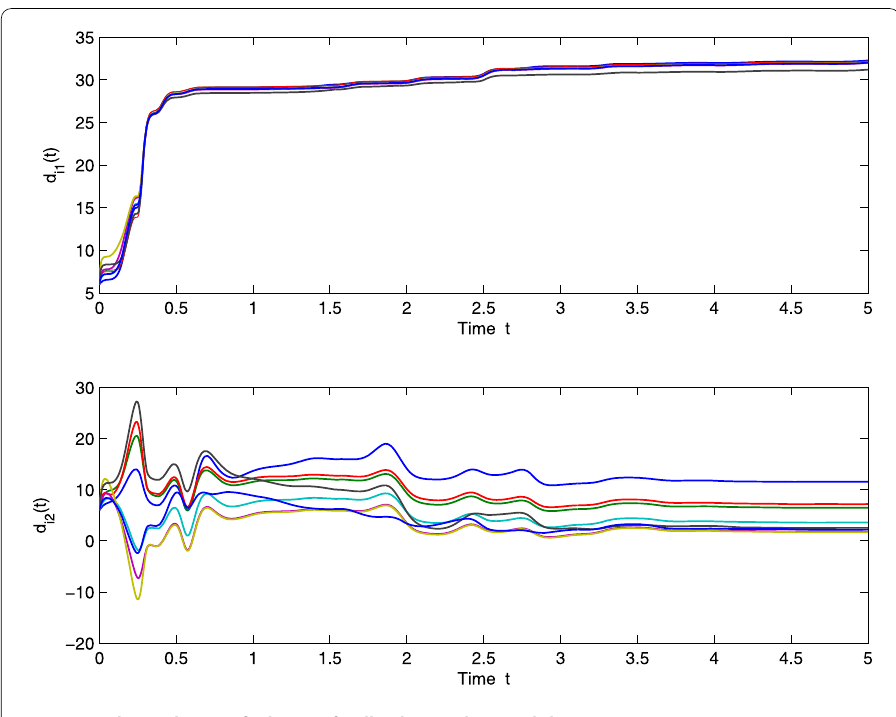
Figure 12 The evolution of adaptive feedback gain d i 1 ( t ) and d i 2 ( t ) ( i = 1,2,...,8).